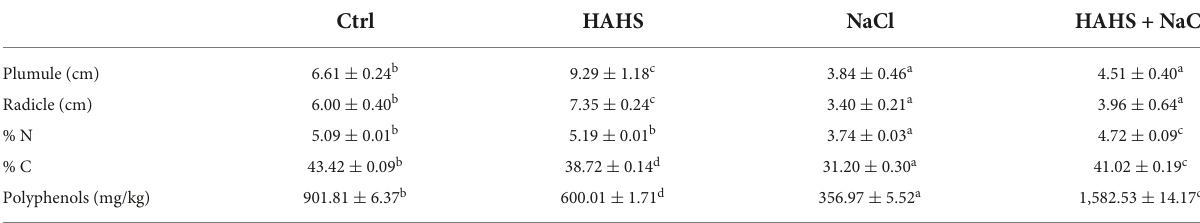
TABLE 1 Growth and biochemical characteristics of habitat-adapted heterologous symbiont (HAHS)-treated (B) and control (C) tomato seedlings under salt stress conditions. Ctrl HAHS NaCl HAHS + NaCl Plumule